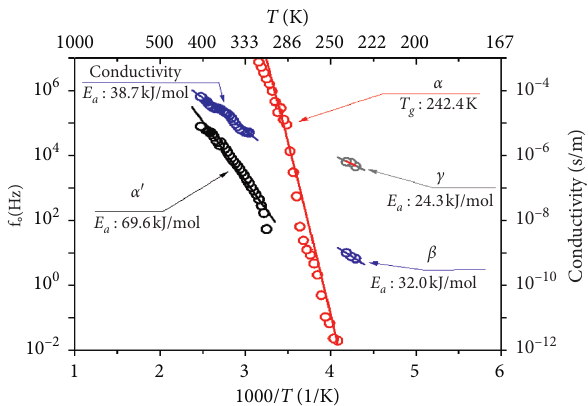
Figure 7: Reciprocal temperature dependence of the central fre- ) of the imaginary loss peak for the α ′ (black circle), α quency ( f 0 (red circle), β (blue circle), c (gray circle), and conductivity (navy circle) processes in NBR. The corresponding solid lines are the fitted results for the relaxation